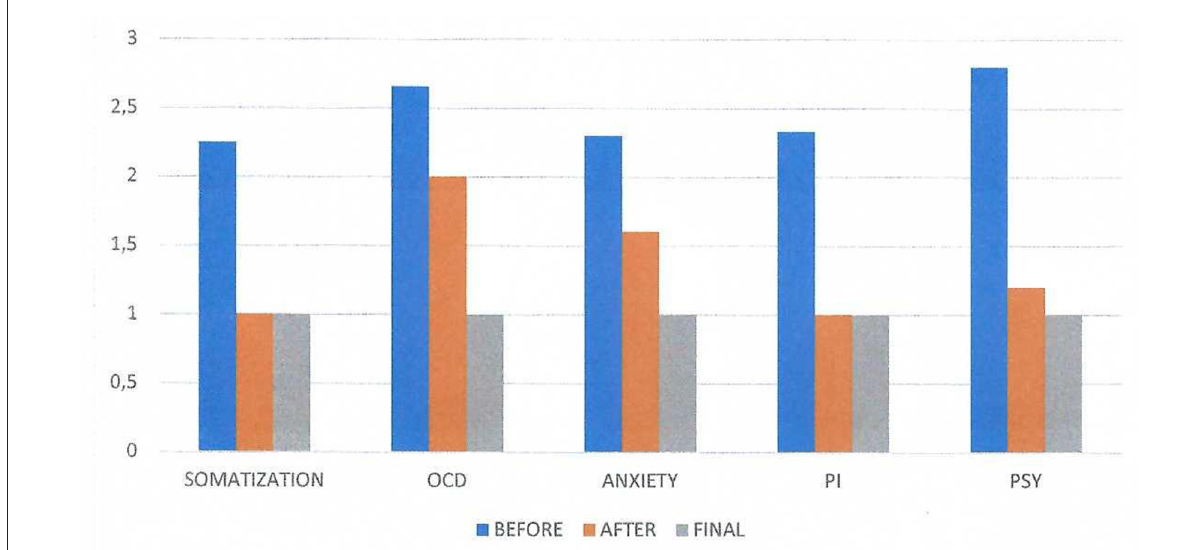
FIGURE2 SCL-90 results on three conditions: before and after the first neurofeedback session and the results of the final session. The term Somatization represents the somatic symptoms that were reported by the subject before the session. There was no difference in the appearance of these symptoms after the session. The abbreviation OCD represents the obsessive-compulsive symptoms before and after the session, the abbreviation PI represents the paranoid ideation before and after the session and the abbreviation PSY represents the Psychoticism (that is the psychotic symptoms) before and after the session. We evaluated the mean scores of each factor and we can observe significant variation in the factors “Anxiety”, “Paranoid Ideation” and “Psychoticis”.